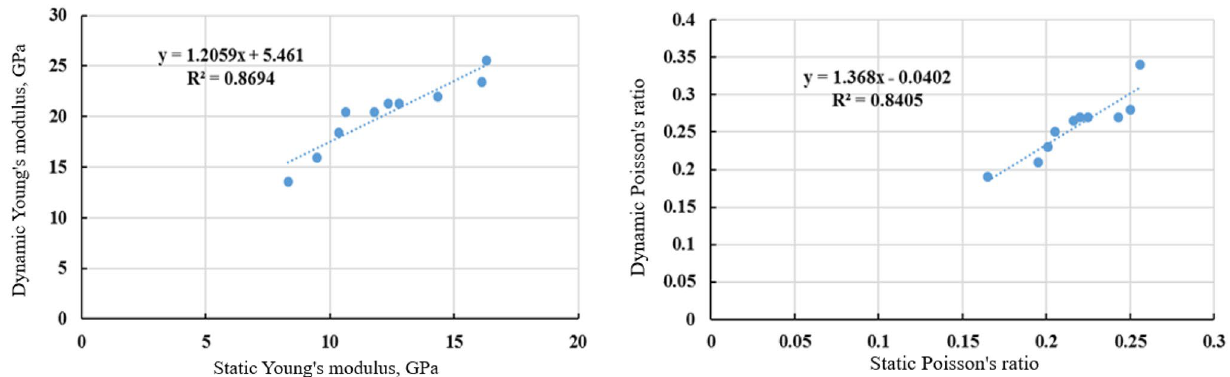
Fig. 8 Calculation results of Dynamic Young's modulus and Poisson's ratio in well V36